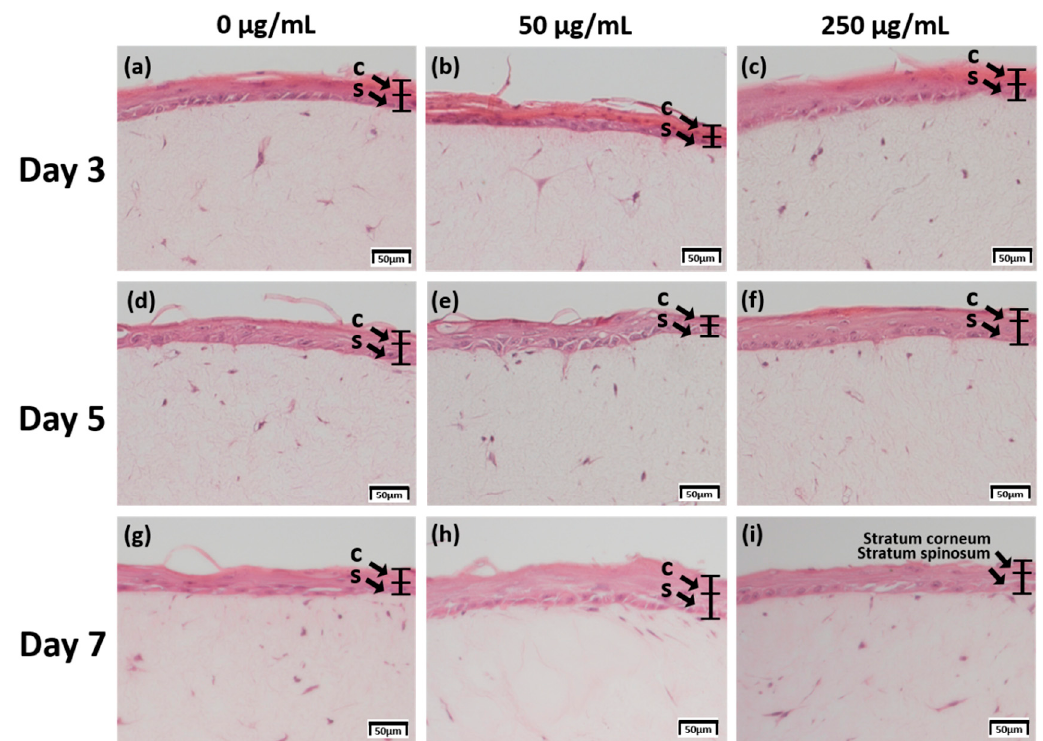
Figure 1. H & E staining images of 3D cell cultured sample for 3 days air exposure using culture media-treated CLLE concentrations of ( a ) 0 μ g/mL, ( b ) 50 μ g/mL, and ( c ) 250 μ g/mL; for 5 days air exposure using culture media-treated CLLE concentrations of ( d ) 0 μ g/mL, ( e ) 50 μ g/mL, and ( f ) 250 μ g/mL; and for 7 days air exposure using culture media-treated CLLE concentration of ( g ) 0 μ g/mL, ( h ) 50 μ g/mL, and ( i ) 250 μ g/mL. (C; Stratum corneum, S; Stratum spinosum)